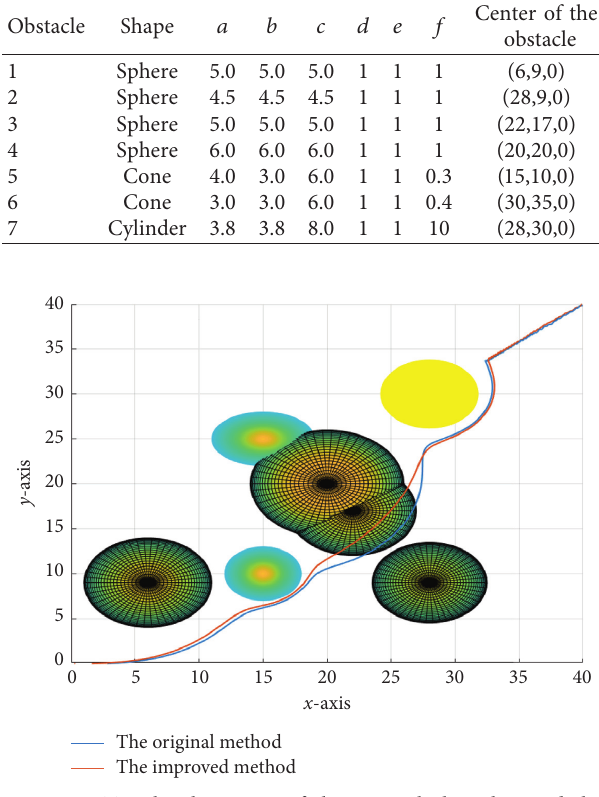
Figure 1: Two height curves of the original algorithm and the improved algorithm.